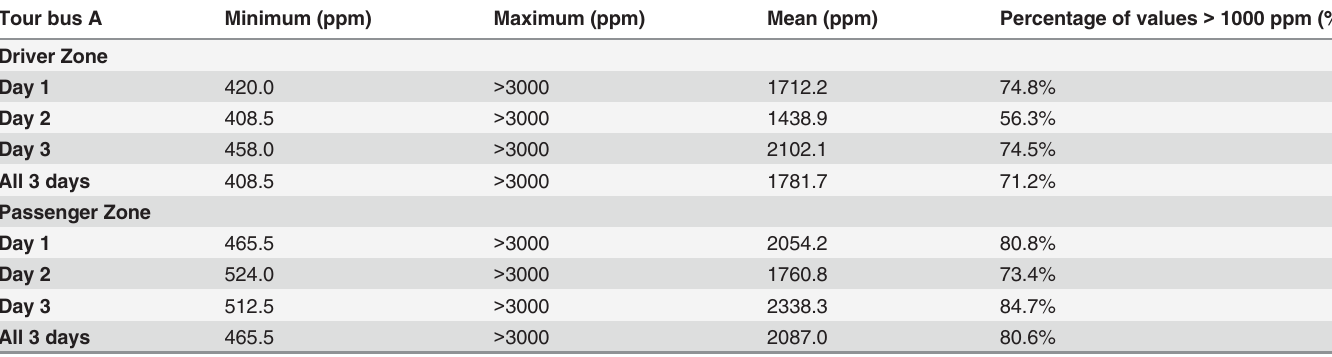
Table 1. Results of CO 2 concentration monitored in tour bus A under real-time traffic conditions. Tour bus